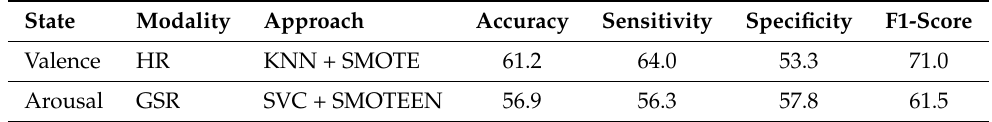
Table 5. Quantitative performance metrics for the severely depressed